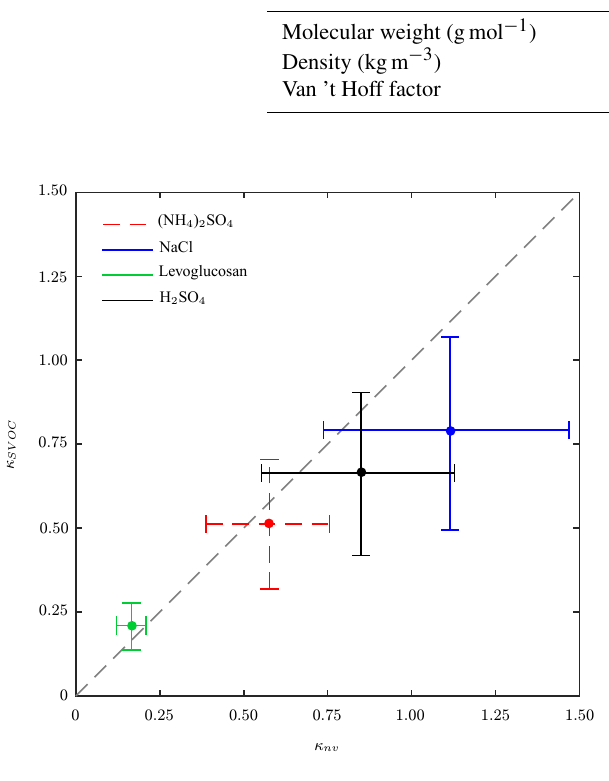
Figure 3. Hygroscopicity including the SVOCs, κ SVOC , plotted against κ nv . The grey dashed line shows equality between the axes, error bars showing the middle 67% of our derived values and the intersections of the error bars depicting the means. Ammonium sulfate is shown in red with dashed error bars, sodium chloride is shown in blue, levoglucosan is shown in green and sulfuric acid is shown in black.